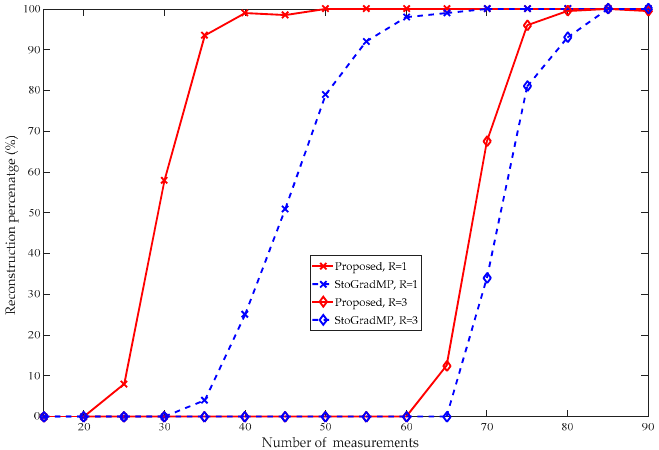
Figure 11. Average running times of the proposed method at different weak selection thresholds ( d = 100, R = 1,3, κ = 0.2,0.4,0.6,0.8, m = 200 : 5 : 300, random low-rank matrix). Figure 12. Reconstruction percentages of the StoGradMP and proposed algorithms (